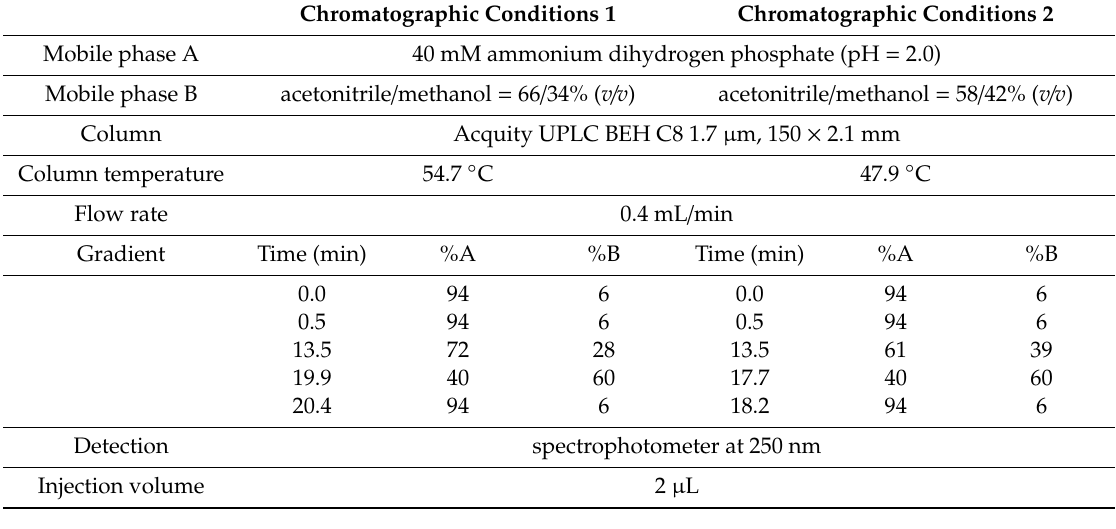
Table 6. Final chromatographic conditions for the UHPLC method developed.